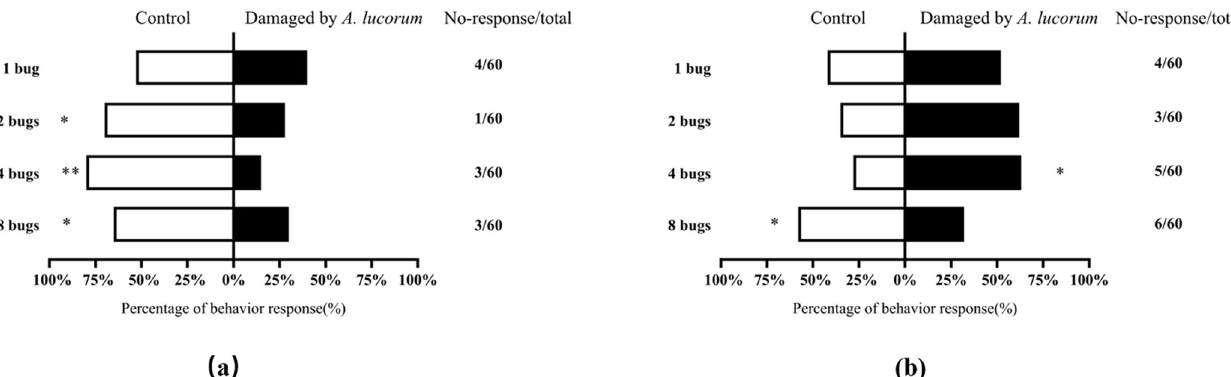
Figure 1. Behavioral responses of insects to damaged cotton plants or health cotton plants volatiles in the Y − tube olfactometer assays. ( a ) behavior responses of A. lucorum ; ( b ) behavior responses of P. spretus . The asterisks were based on the χ 2 analysis. “*” denoted difference at the p < 0.05, and “**” denoted difference at the p < 0.01.